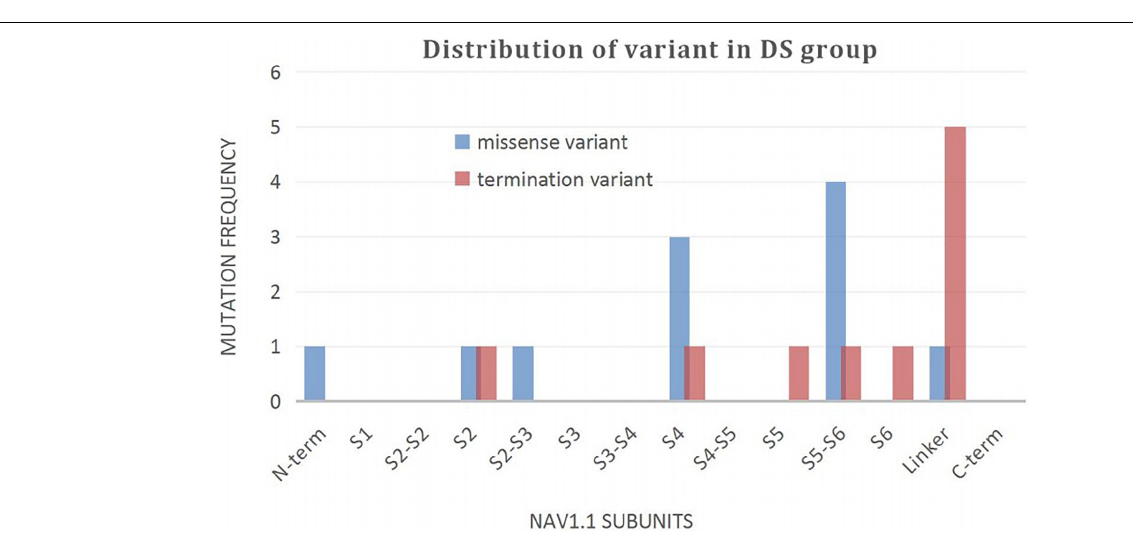
FIGURE 2 | Distribution of variant frequency of 39 patients with point variant in our study.